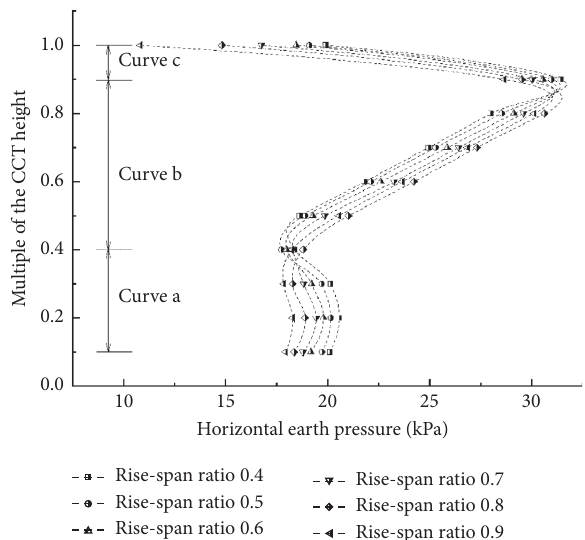
Figure 9: Variation of lateral earth pressure for case S2 on the side of